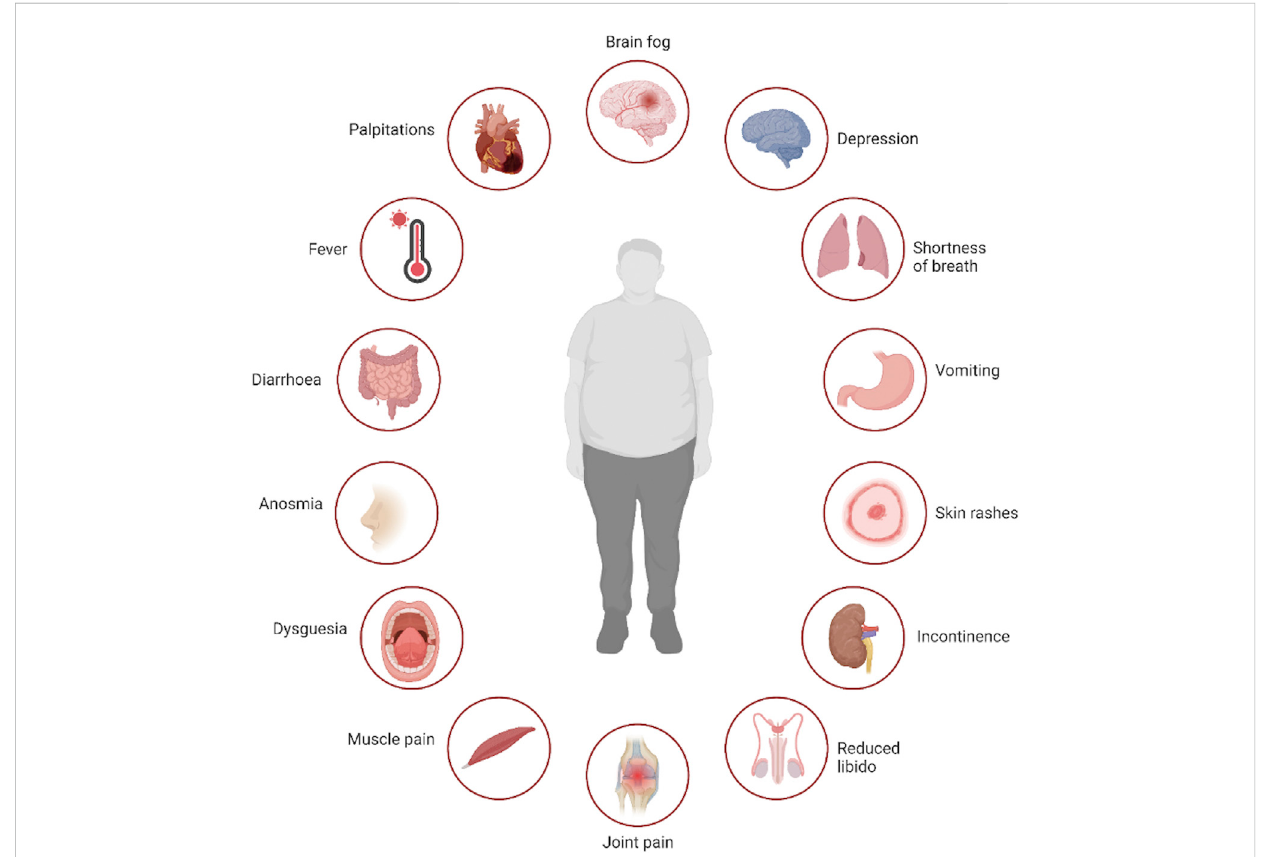
FIGURE 1 Multisystemsymptomsassociatedwith longCOVID .Legend:SelectionofsymptomsreportedbypatientssufferingwithlongCOVID,demonstrating the multi-system nature of the disease. Created with